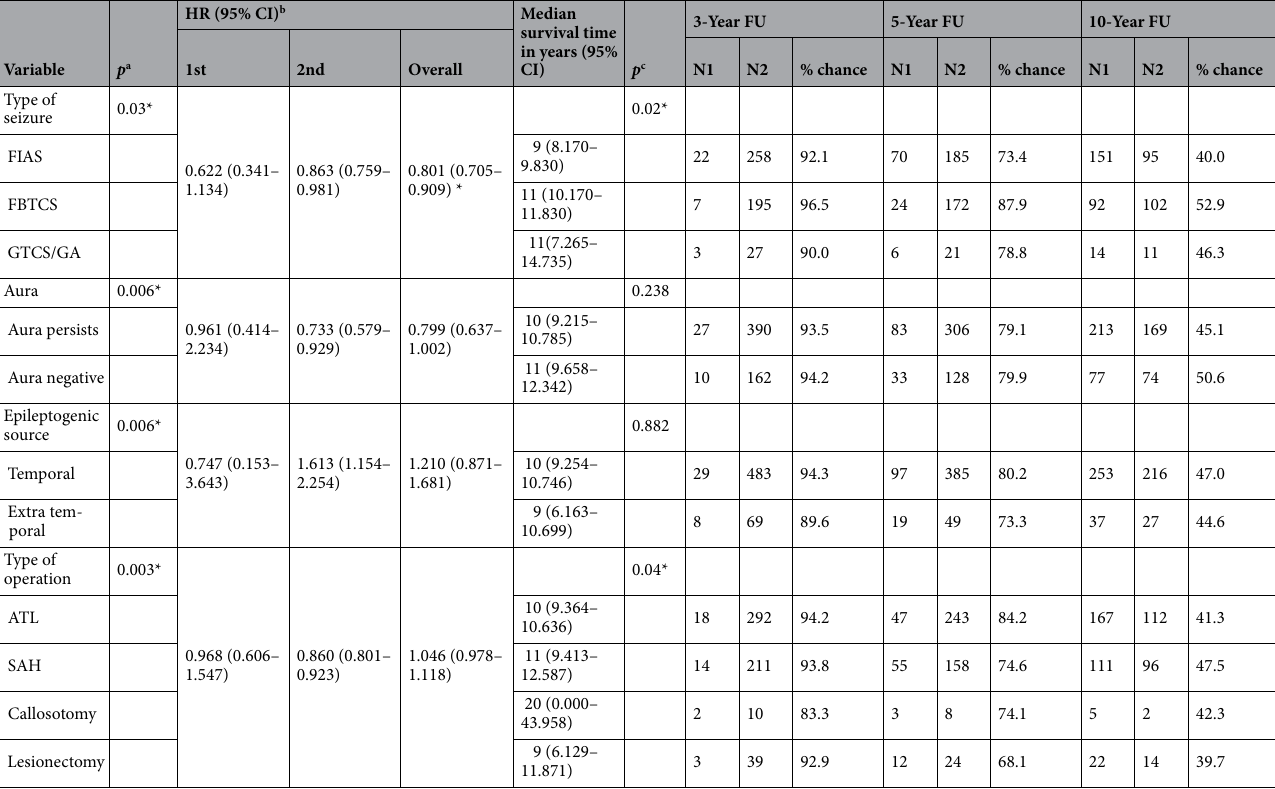
Table 6. Postoperative seizure-free outcome analysis according to the type of surgery, aura, epileptogenic source and type of operation. FU Follow-up, FIAS Focal impaired awareness seizure, FBTCS Focal to bilateral tonic clonic seizure, GTCS/GA Generalized tonic clonic seizure generalized absence, ATL Anterior temporal lobectomy, SAH Selective amygdalohippocampectomy, 1st 1st period, 2nd 2nd period, HR Hazard ratio, CI Confidence interval, N1 Number at risk, N2 Number of remaining cases, % chance % chance of being seizure free at the end of follow-up. a Chi-square test. b Cox regression analysis of seizure free. c Kaplan–Meier analysis with the log-rank test. *Statistically significant at p <